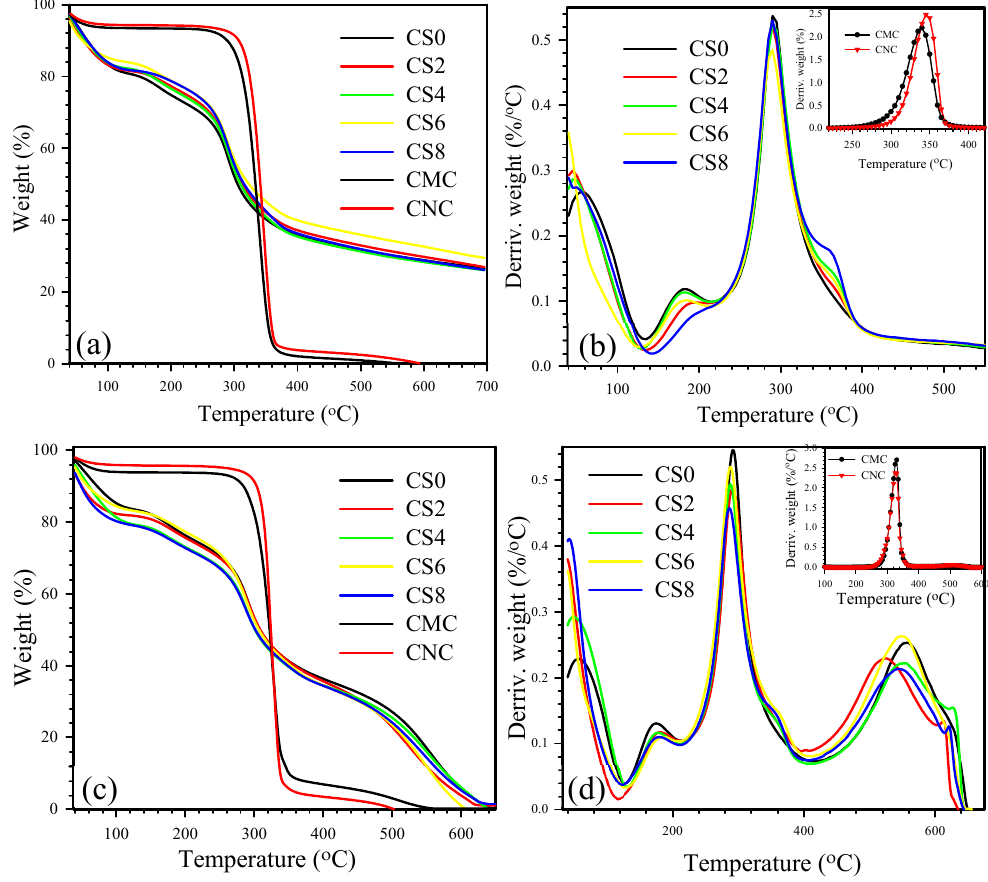
Figure 6. Thermal decomposition curves of CS0, CS2, CS4, CS6, CS8, CMC, and CNC: ( a ) and ( b ) N 2 environment, and ( c ) and ( d ) air environment.